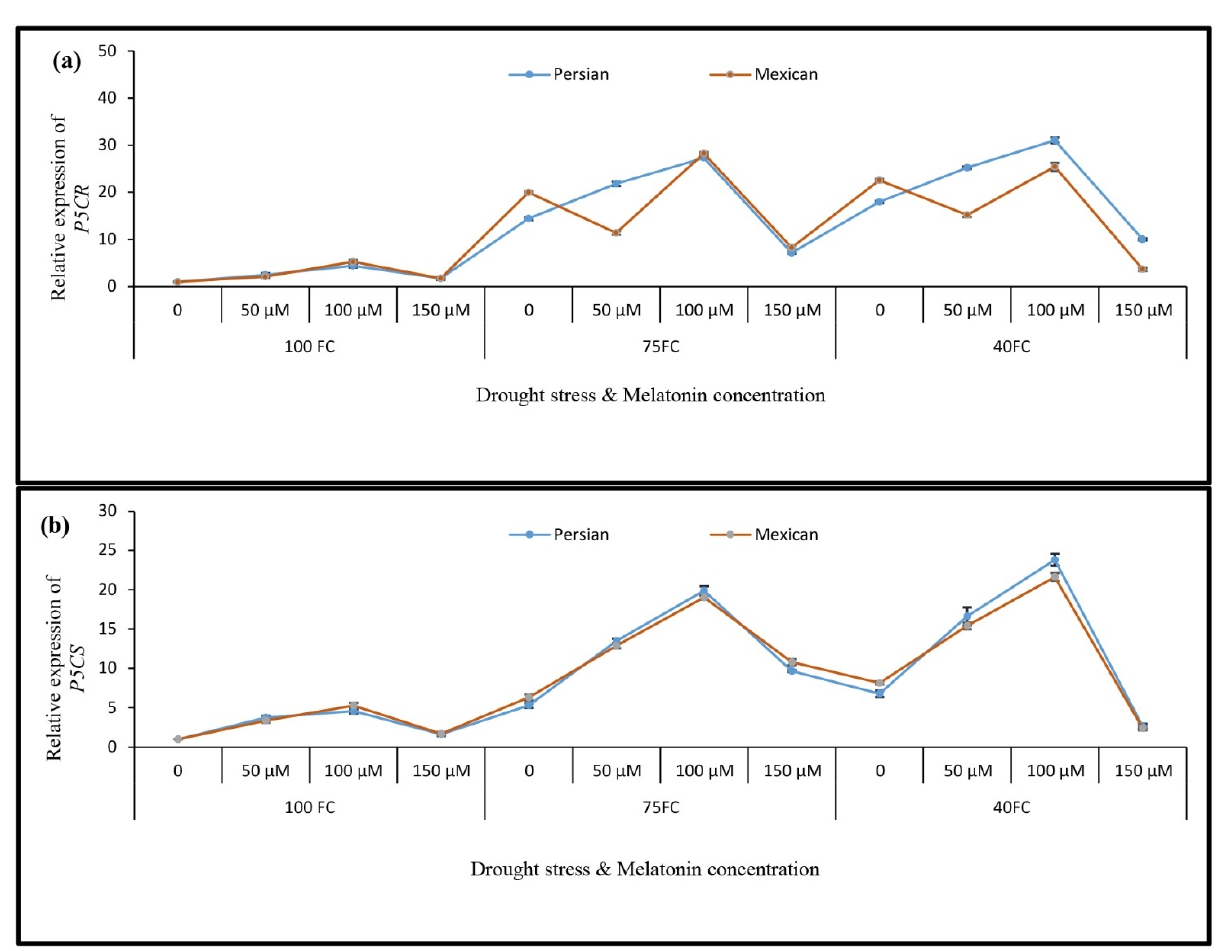
Figure 4. The effect of different concentrations of exogenous melatonin, Citrus species, and various levels of drought stress on the expression of proline biosynthesis genes including ( a ) pyrroline-5-carboxylate reductase, P5CR and ( b ) pyrroline-5-carboxylate synthase, P5CS . Data describe the means of three biological replicates with three technical replicates each. Error bars represent standard deviation (SD).